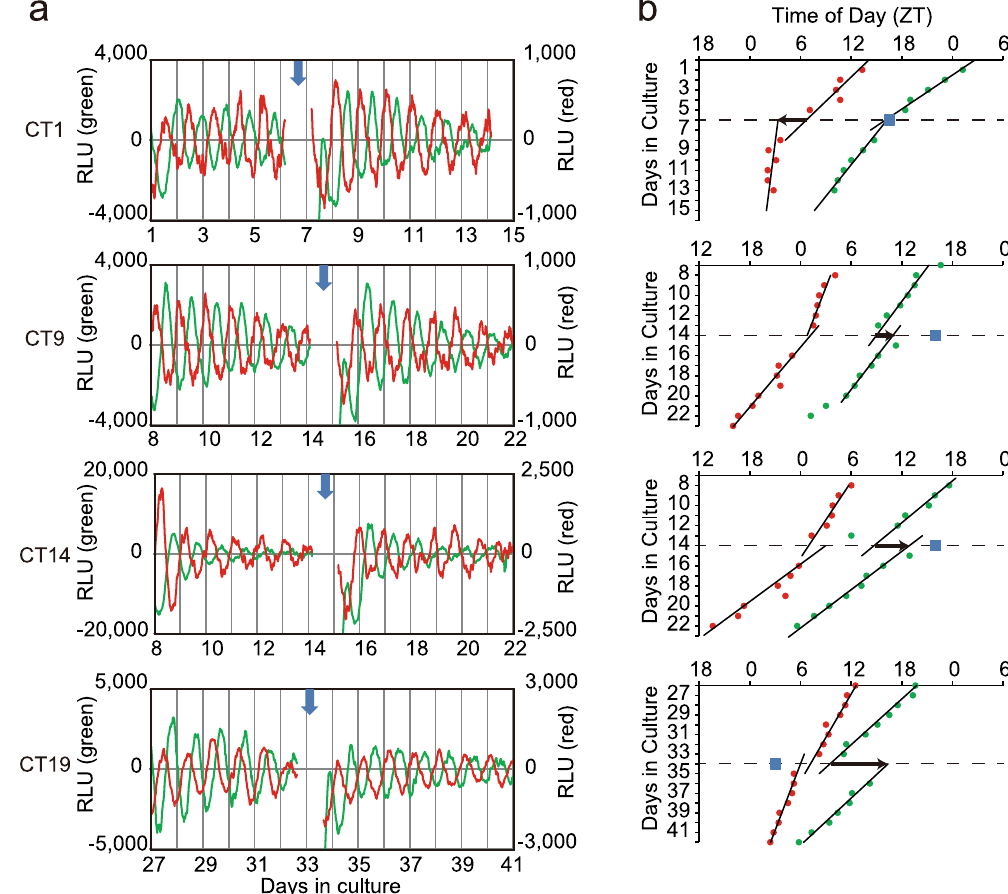
Figure 3. Phase shifts of circadian Bmal1 and Per2 rhythm in the neonatal SCN slices in response to medium exchange ( a ) Representative records of phase shifts in response to medium exchange at 4 different phases. The circadian rhythms before and after medium exchange were illustrated for Bmal1 (green) and Per2 (red). See also the legend for Fig. 1a. The time of medium exchange was indicated with a vertical arrow. ( b ) Successive circadian peaks with regression lines fitted to them before and after medium exchange in the same SCN as used for ( a ). The abscissa indicates times of day as ZT and the ordinate days in culture. A square column in each panel indicates the time of medium exchange. A horizontal arrow indicates the direction and magnitude of phase-shifts calculated from two regression lines (see